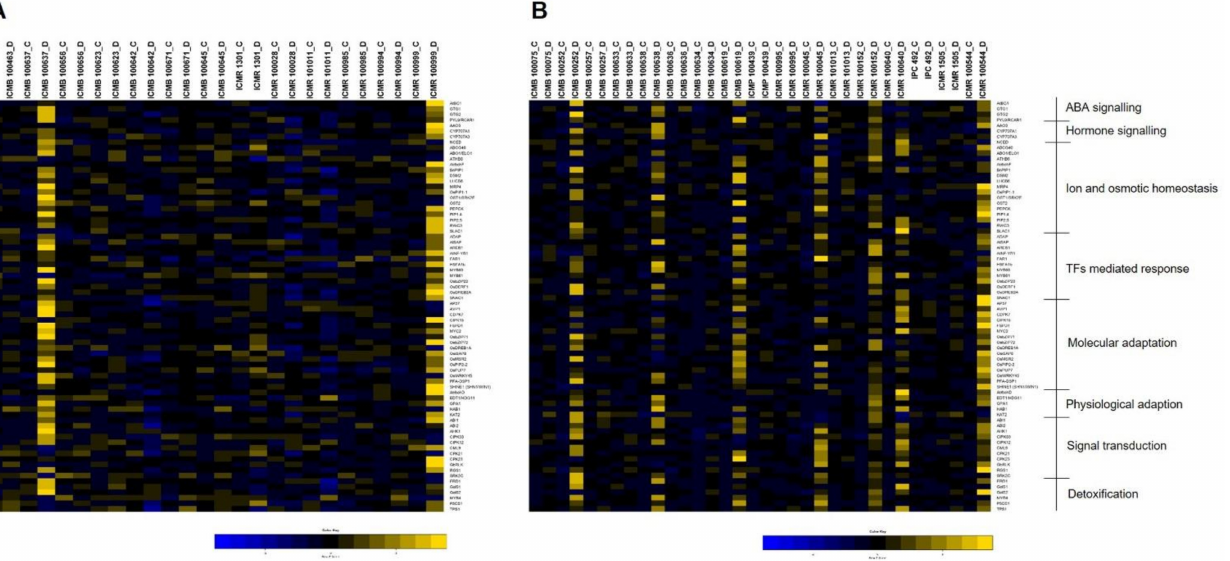
Figure 7. The heat map of 74 drought genes expressed in the ( A ) medium and ( B ) late maturity group. The genotypes under drought (with suffix D) are compared with their respective control (with suffix